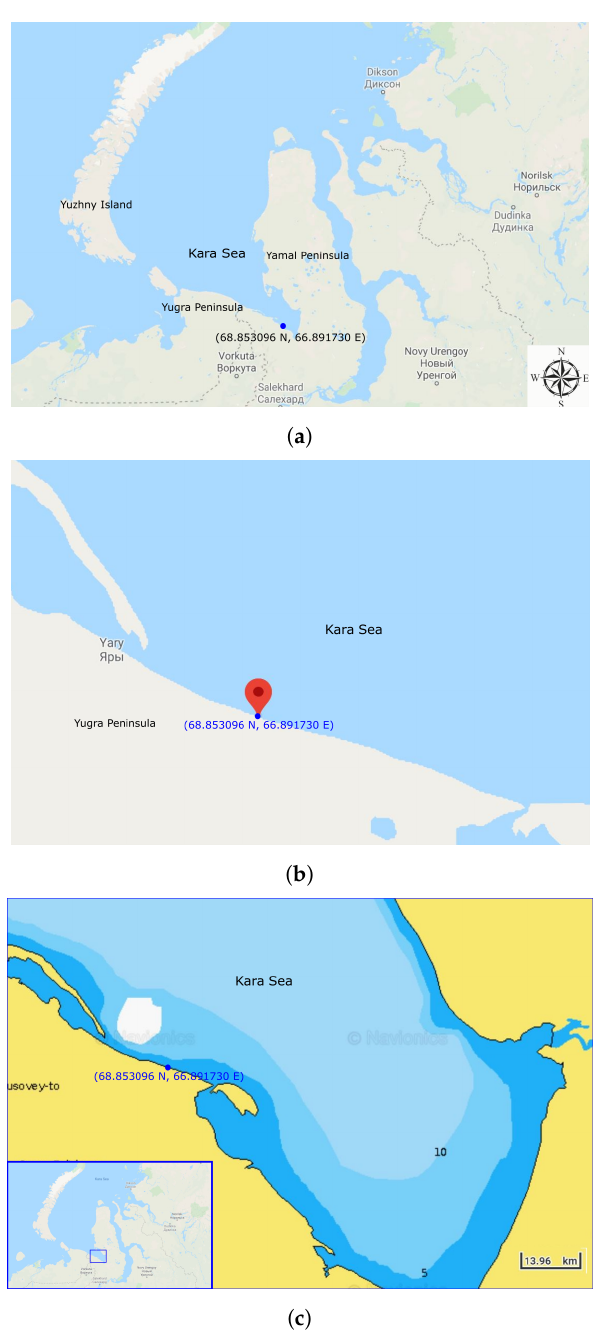
Figure 1. The study location is situated along the coast of the Kara Sea and in between the Yugra Peninsula and the Yamal Peninsula. The sea is shallow and funnel-shaped, which makes it susceptible to large storm surges (image source: a and b: Google Earth and c: navionics.com). ( a ) The study location is along the Kara sea (68.853096° N, 66.891730° E). ( b ) The beach is located near the 69° N latitude; straight but the orientation is around 45° with horizontalline. ( c ) Bathymetry of the study area. Near the shore, the depth is 10